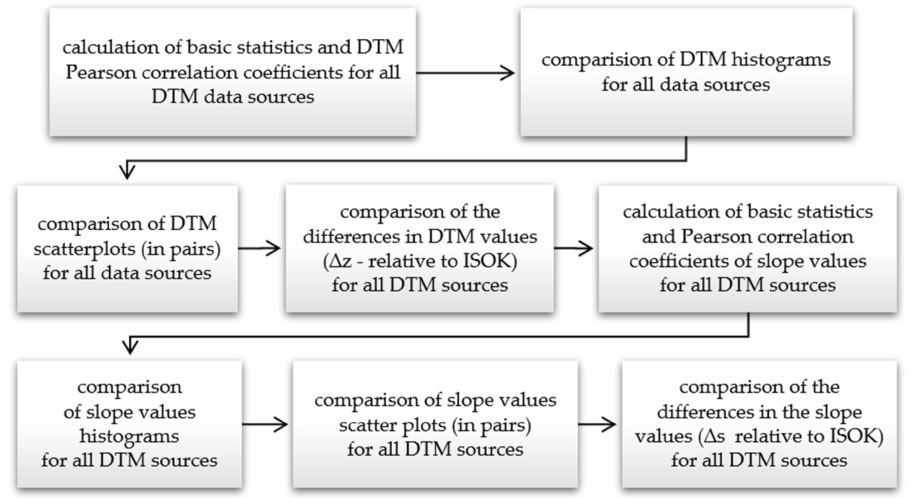
Figure 5. The methodology of a comparative analysis of the DTM and slopes values (stage